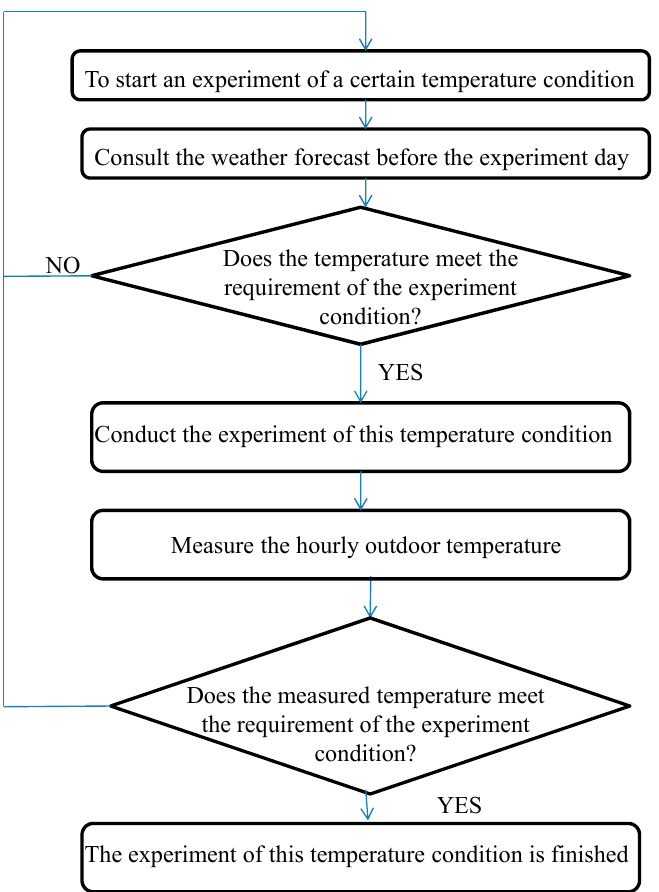
Figure 1. Flowchart to select an experiment day of a certain temperature condition.